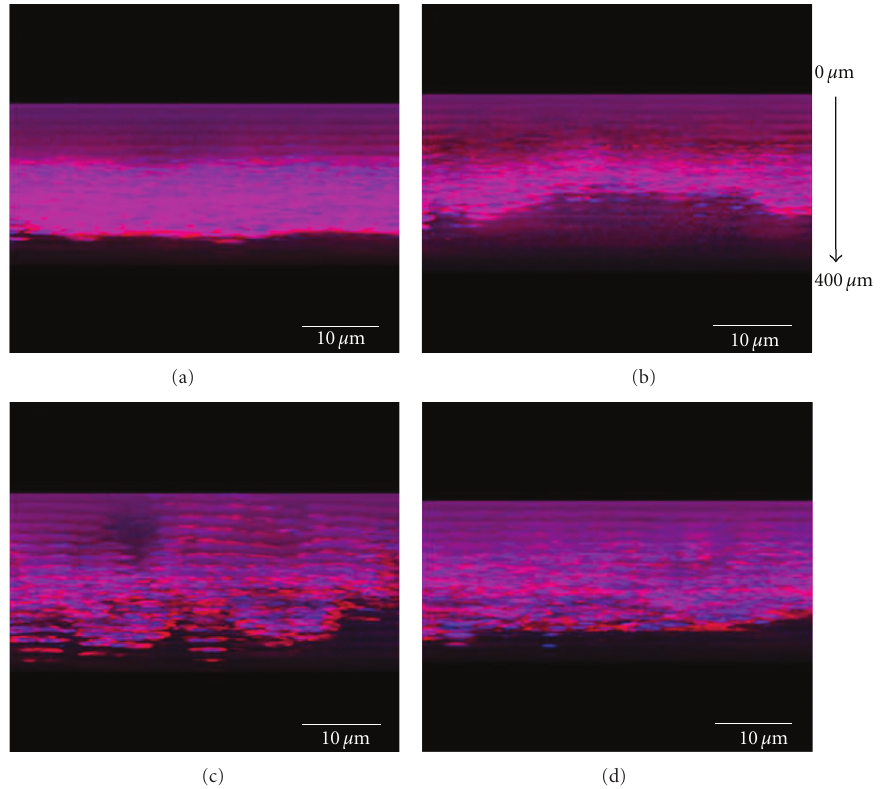
Figure 2: Multiphoton images of Caco-2 cells treated with PEG 8000 and various bacterial strains. Uninfected cells were served as control (a). Caco-2 cells were infected with commensal strains, 261 and HS4 (b, c), and EPEC (d). The maximum depth of invasion was seen in sca ff olds infected with HS4. The overall thickness of the sca ff old was approximately 400 µ m. The actin filaments are shown in red and the DAPI staining of nuclei are shown in blue. Bar length = 10 µ m.